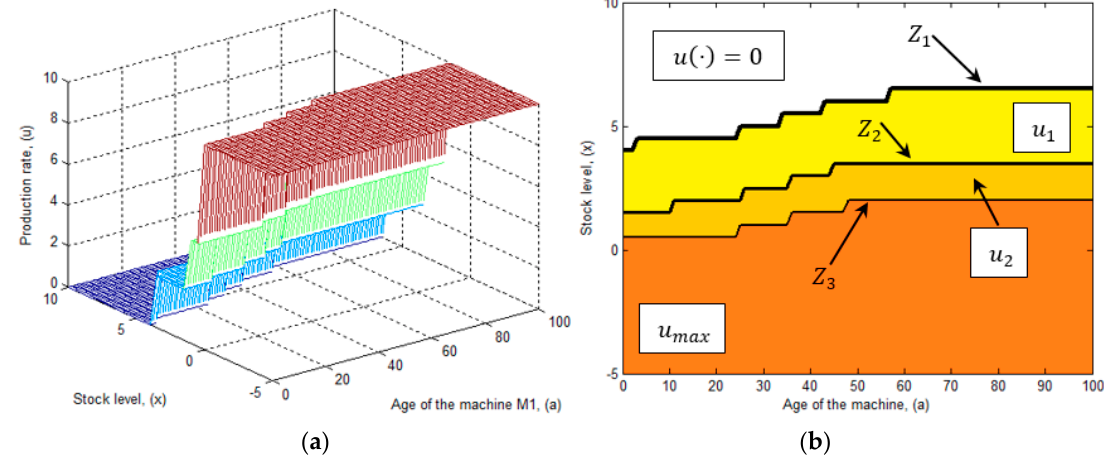
Figure 5. Production policy. ( a ) Production rate; ( b ) Production trace.